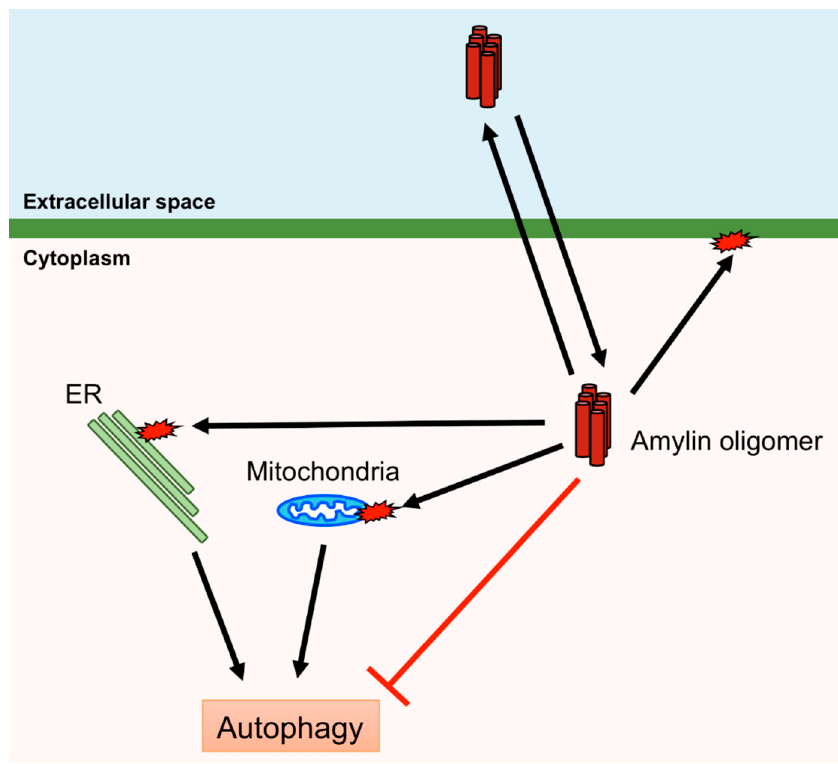
Figure 4. Cytotoxic effects of human amylin oligomers. Human amylin oligomers permeate and disrupt the plasma membrane and induce damage to mitochondria and the endoplasmic reticulum (ER). Autophagy can remove damaged mitochondria and the ER. However, human amylin oligomers inhibit autophagy.